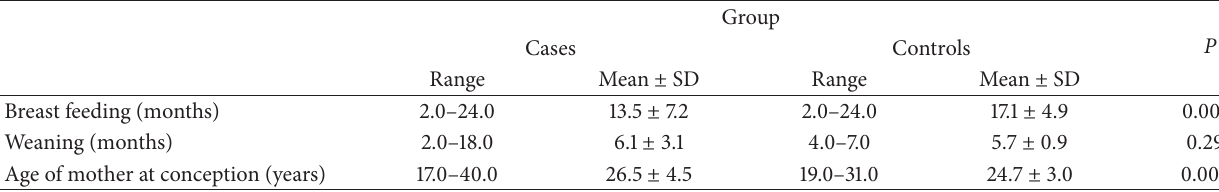
Table 2: Comparison between studied groups as regards perinatal data.